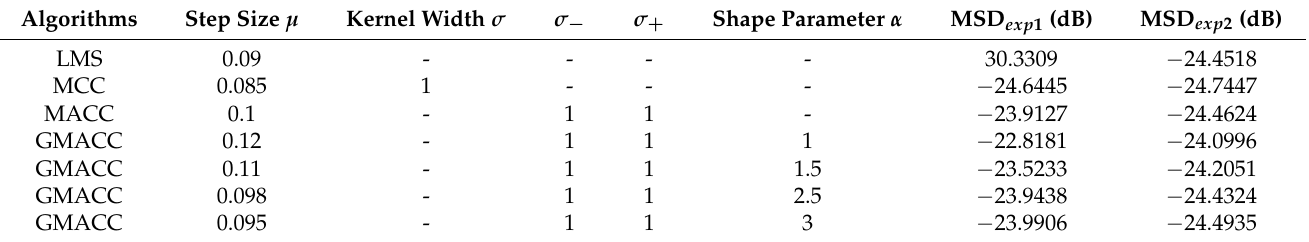
Table 3. Parameters and steady-state MSD of the algorithms in simulation 1 and simulation 2.